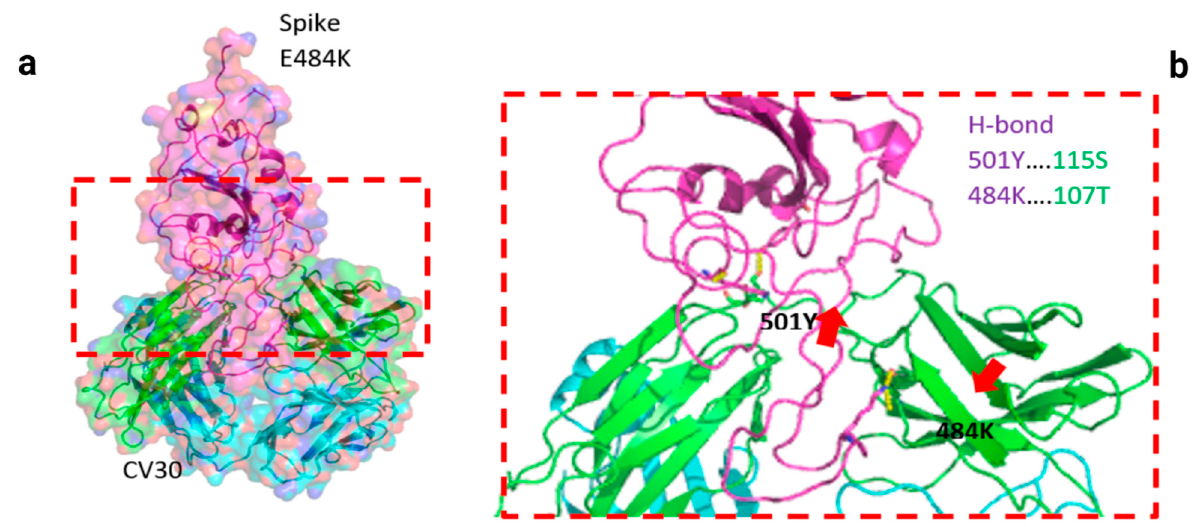
Figure 5. Docking structures of the interaction of B.1.351 mutant SARS-CoV-2 S-RBD protein in complex with a potent neutralizing CV30 antibody ( a ) and hACE2 ( b ). The dashed line indicates the hydrogen bond.